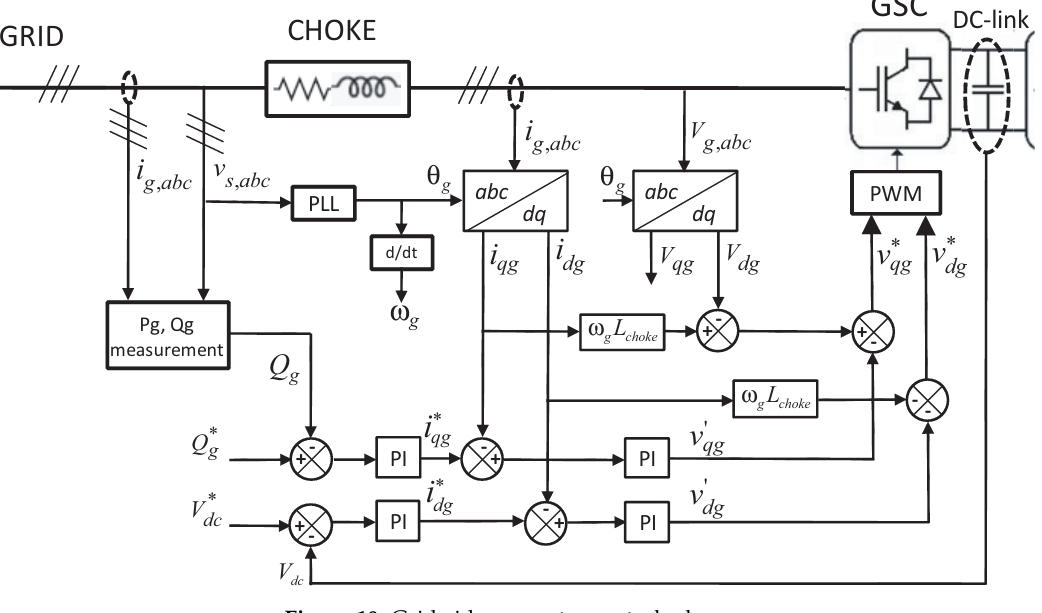
Figure 10. Grid-side converter control